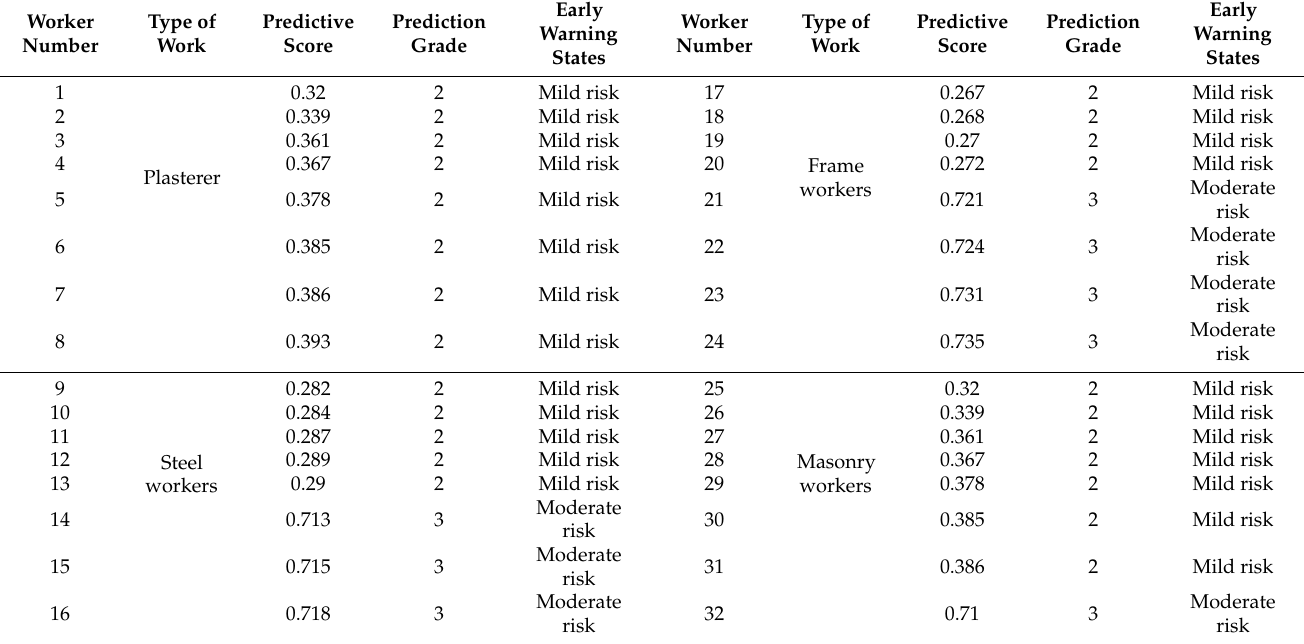
Table 15. Prediction results of workers in the primary school construction